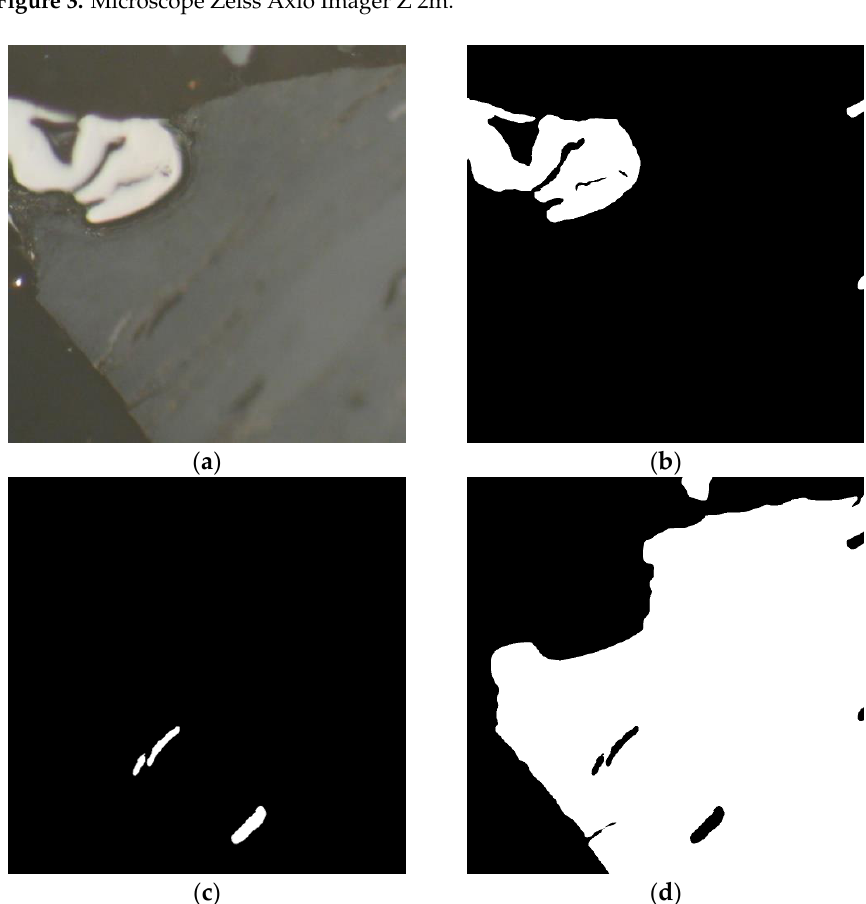
Figure 4. Example of the input image and accompanying masks: ( a ) the input image; ( b ) mask for the inertinite; ( c ) mask for the liptinite; ( d ) mask for the vitrinite.